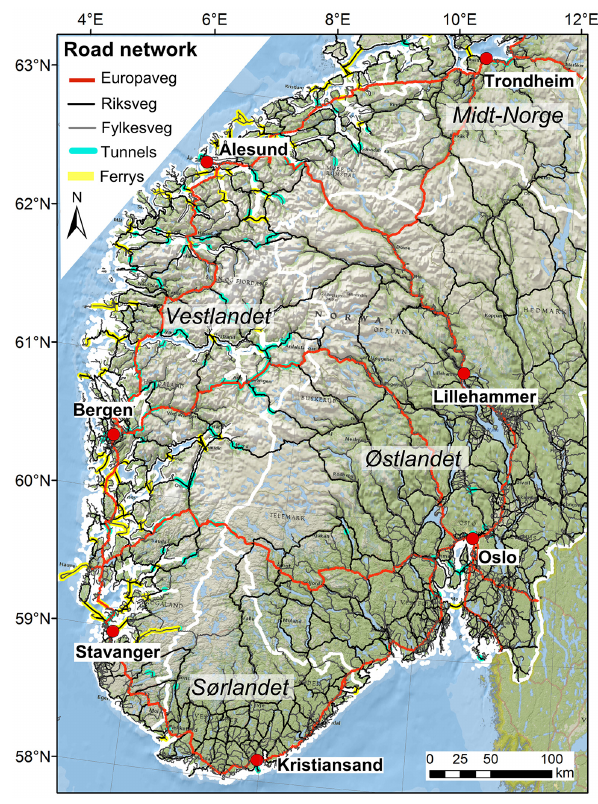
Figure 1. Study area and road network connecting major cities in southern Norway. All traffic data were provided by the Norwegian Public Road Administration Statens Vegvesen . Road characterisa- tion and regions delineated by white boundaries correspond to Nor- wegian